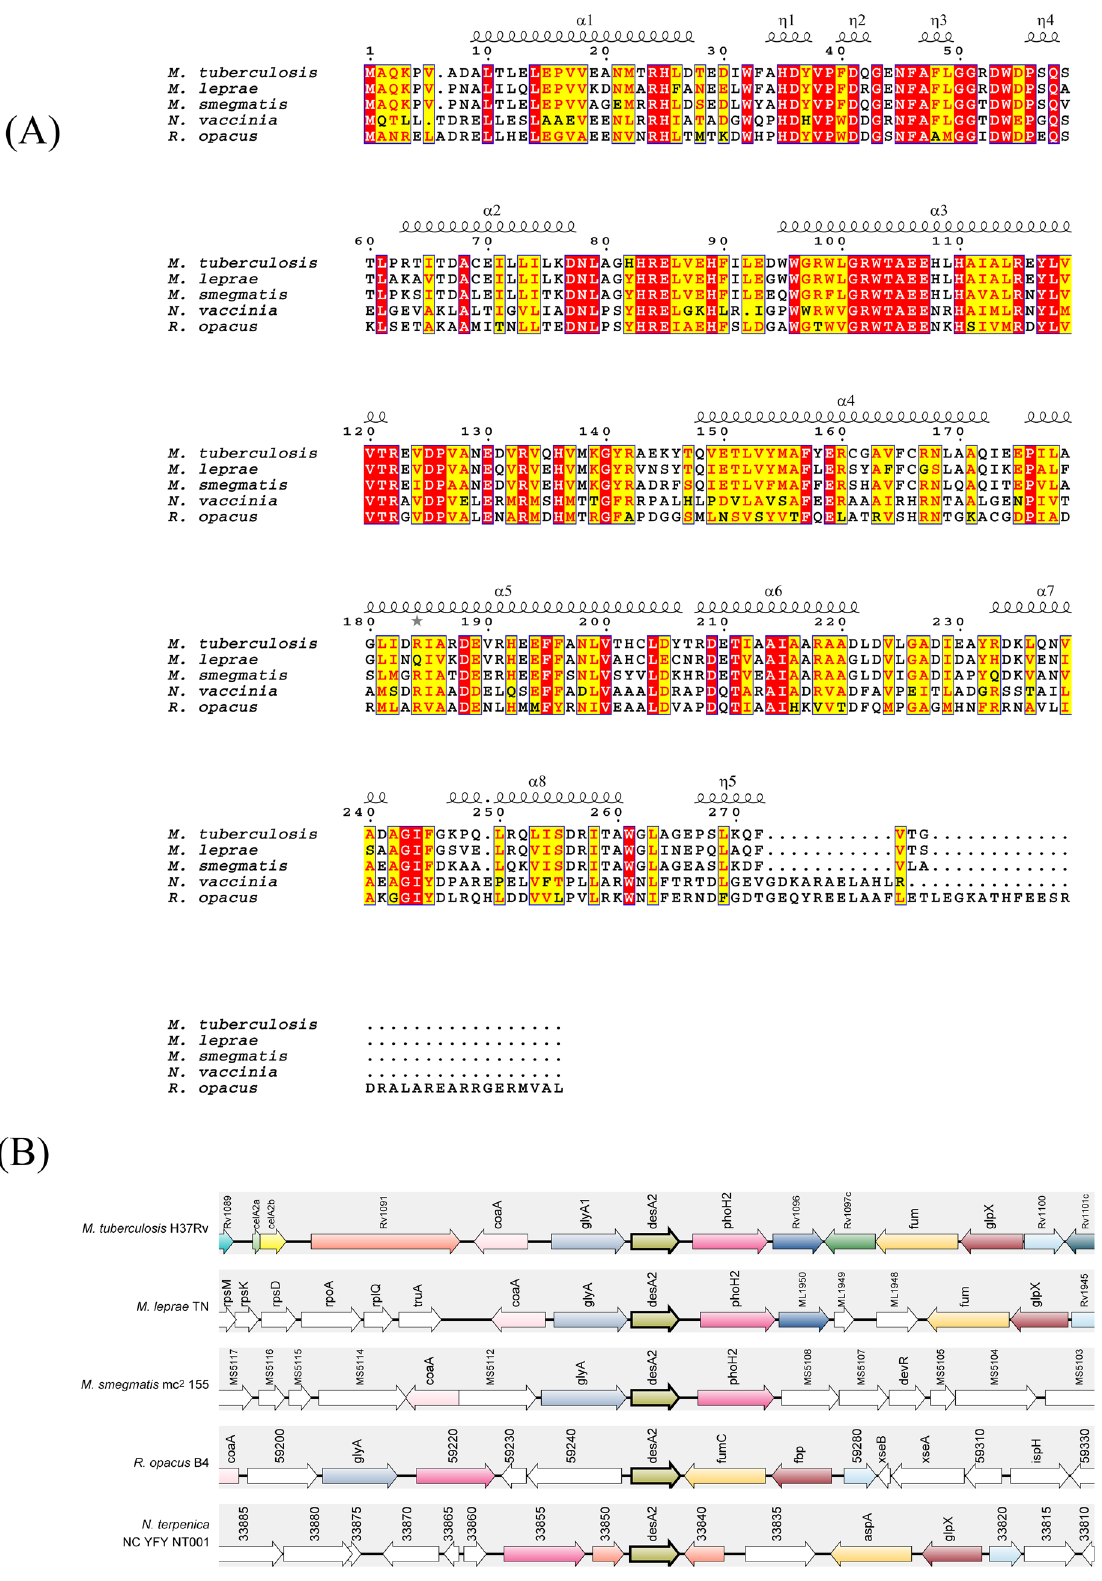
Figure 2. DesA2 is present in mycolic acid producing species that encode a FAS-II ( A ) Multiple sequence alignment of DesA2 orthologs ( B ) Genomic maps of regions containing desA2